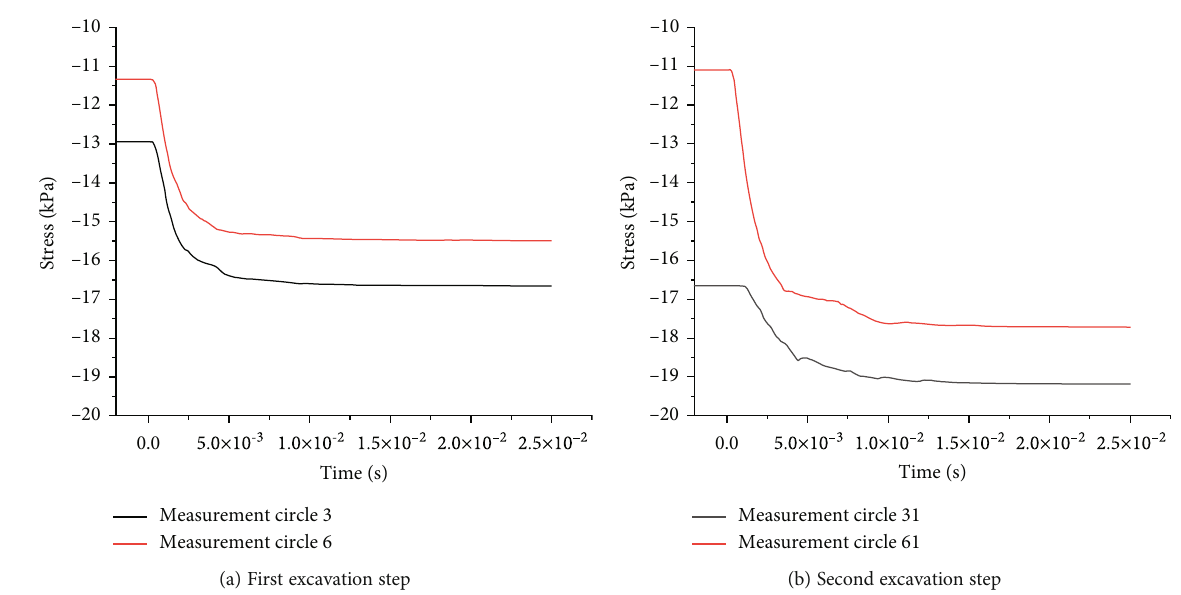
Figure 11: Stress evolution in the overlying strata at the upper left-hand corner of the roof and the lower right-hand corner of the fl oor after the fi rst excavation step (measurement circles 3 and 6, respectively) and after the second excavation step (measurement circles 31 and 61, respectively).